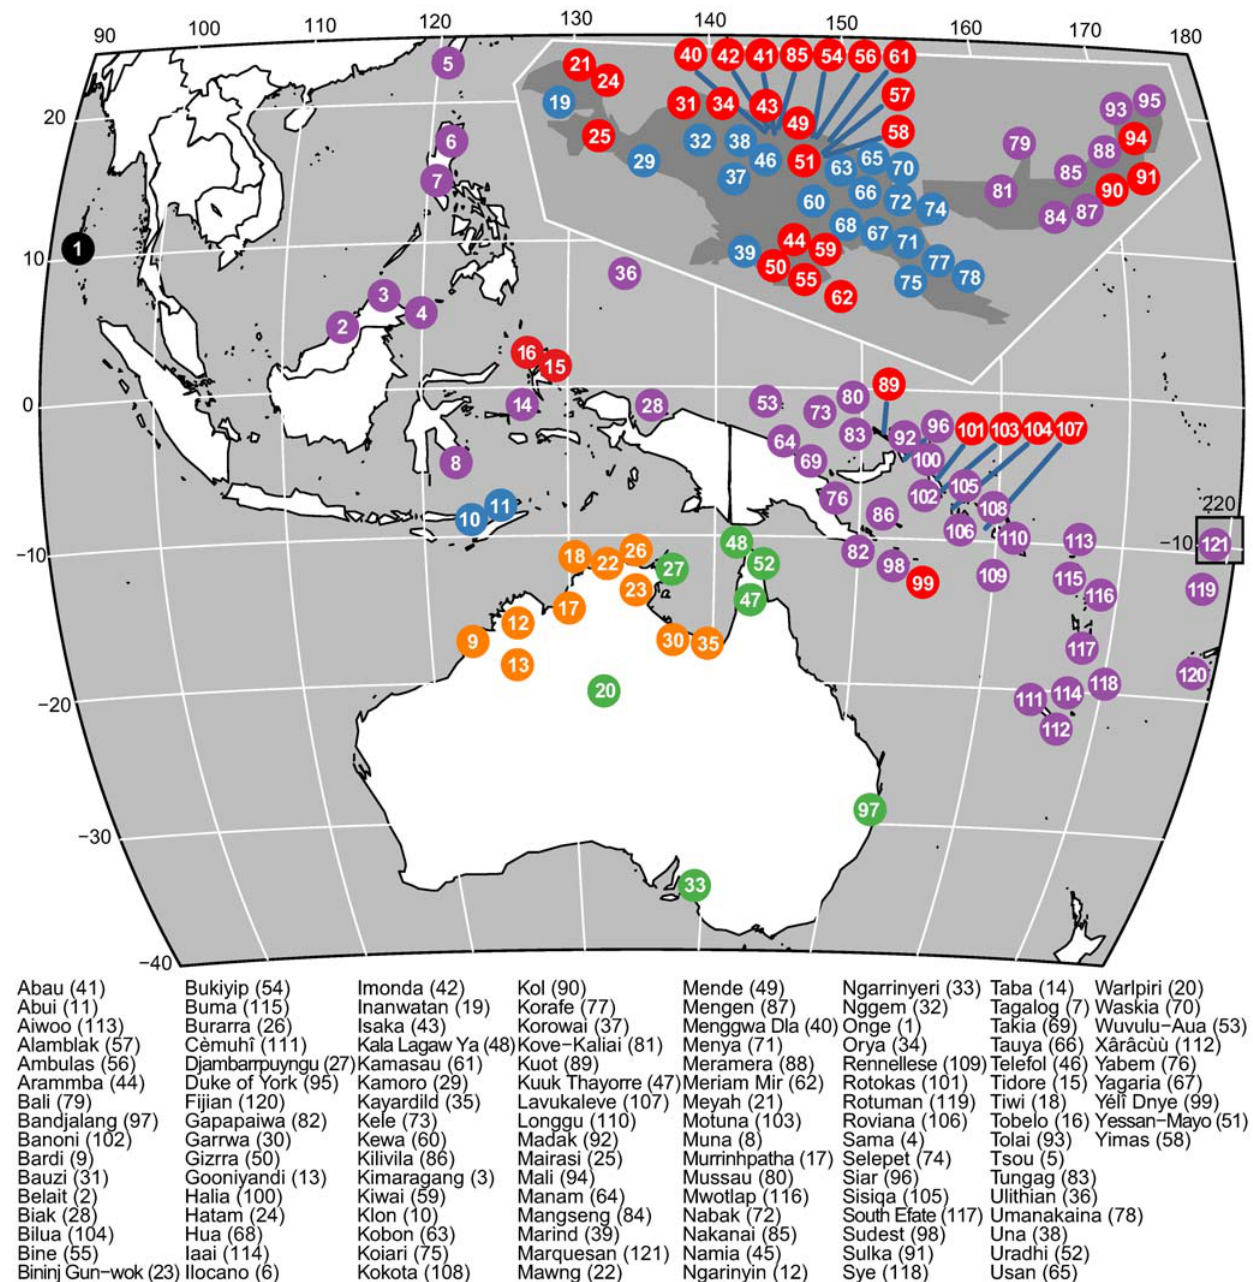
Figure 1. Geographic location and broad genealogical affiliation of the 121 languages in the sample (numbered west to east).